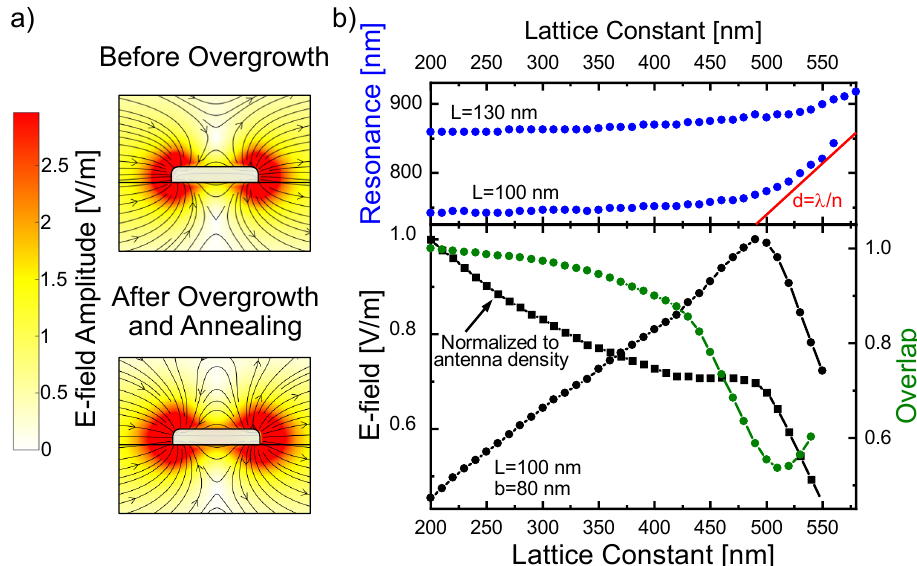
Figure 2. Theoretical results: ( a ) Calculated electric field strengths as colormaps including vector field for resonant excitation for non-overgrown and overgrown antennas with a width w = 70nm, length L = 110nm, thickness h = 20nm, and lattice constant of x = 400nm. ( b ) Blue: Resonant wavelength as a function of the antenna length. Red: Analytically calculated value for the lattice resonance. Black dots: Maximum electric field of an antenna with length L = 100nm and width w = 80nm. The highest electric field occurs for a lattice constant of 500nm. Black squares: If normalized to the number of antennas in one array, the maximum electric field shifts to smaller lattice constants. Both black curves belong to the left axis. Green: Overlap between the electric field and the photoluminescence signal of the nanocrystals. The overlap is higher for smaller lattice constants.